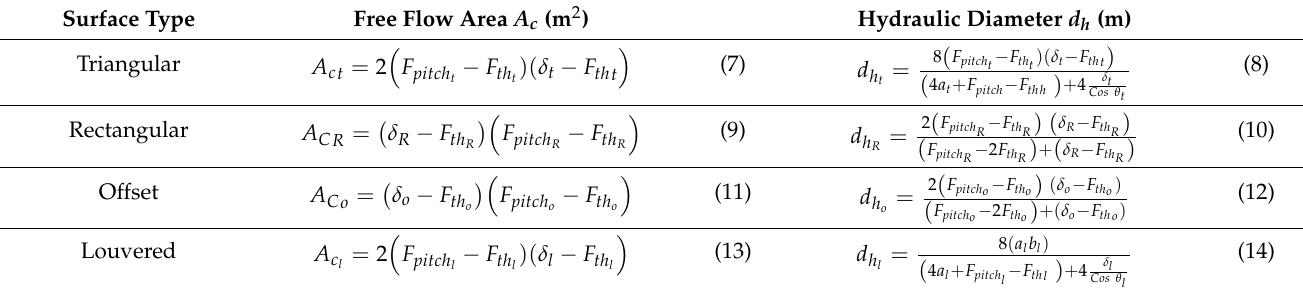
Table 1. Free flow area and hydraulic diameter for triangular, rectangular, offset, and louvred surfaces. Surface Type